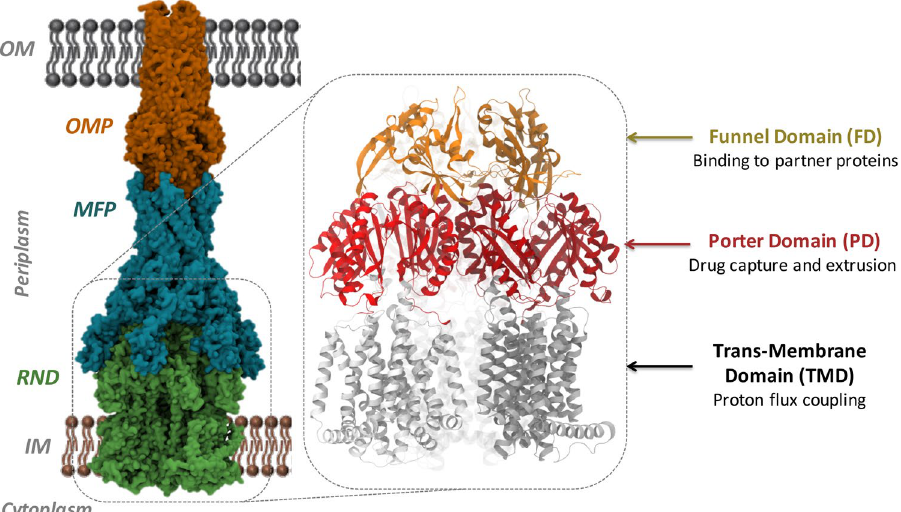
Figure 1. Structure of the RND tripartite pump AcrAB-TolC. AcrAB-TolC pump is shown here with AcrB as the RND component, AcrA as the MFP and TolC as the OMP. In the inset, the general structure of an RND transporter is displayed, where the three main domains (TMD, PD, and FD) are indicated.